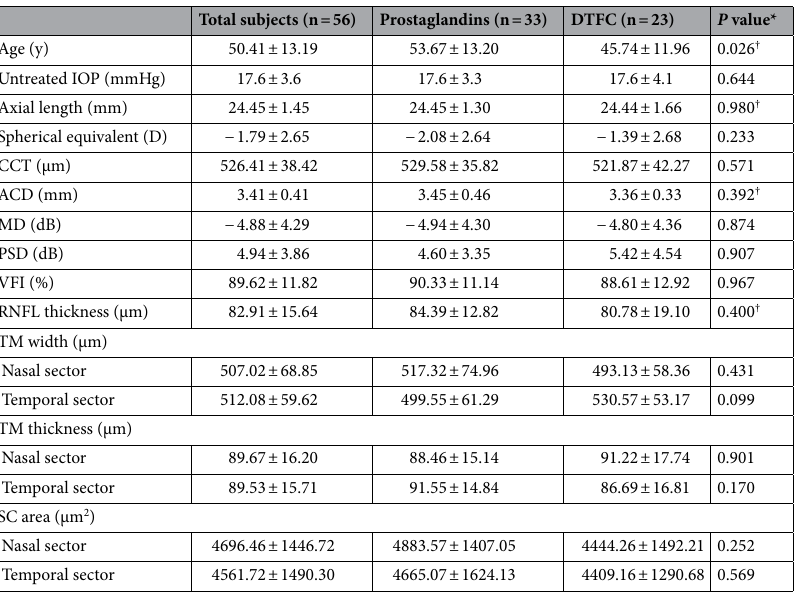
Table 1. Baseline Characteristics of the Subjects. *Mann–Whitney U test, † Independent t-test.